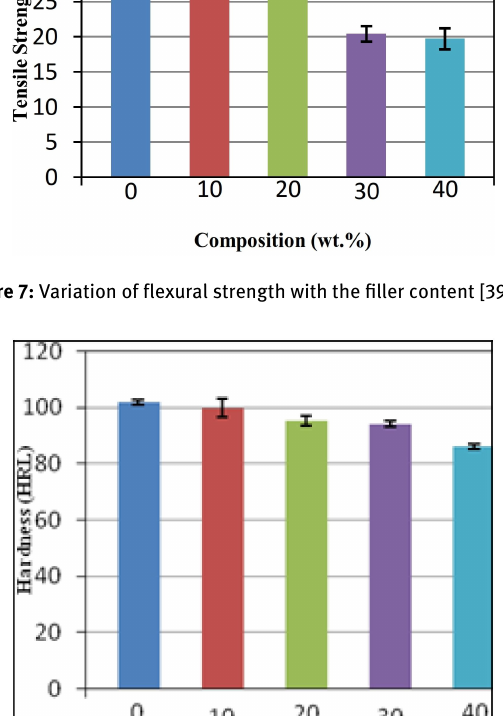
In a study using RH and epoxy as constituent materi- als[39]theflexuralstrengthandimpactstrengthwereseen to be decreasing with respect to pure epoxy that can be attributed to poor interfacial adhesion between fibre and matrix at higher filler loading and to the tendency of RH to agglomerate.